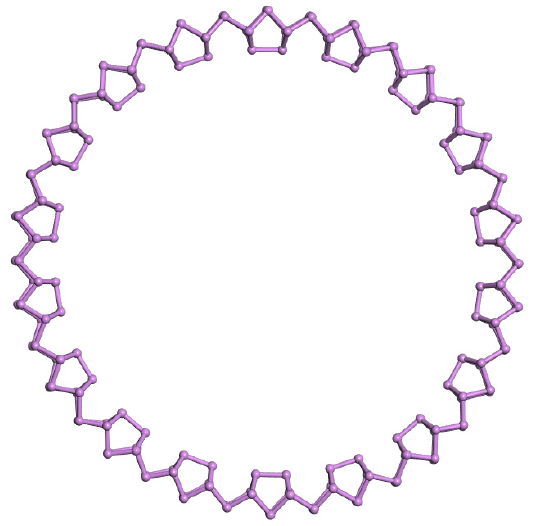
Figure 7. Possible structure for As 180 cluster.